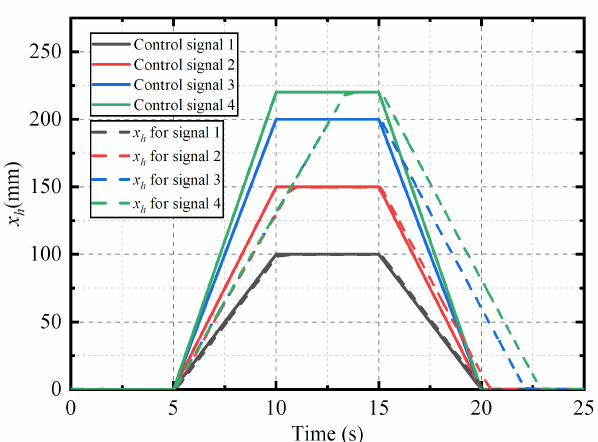
Figure 19. Displacement output, x h , at different control singals when depth is 11